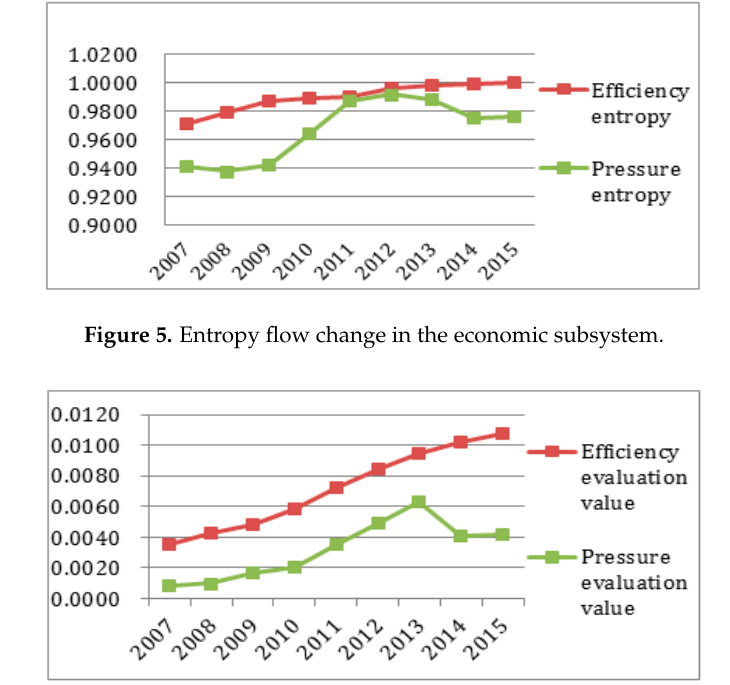
Figure 8. Evaluation value change in the ecological subsystem. Figure 9 shows that the social efficiency entropy flow has a smooth growth between 2007 and 2009, and a sharp decrease in 2010, then, it remains steady from 2010 to 2013, while at the same time, the pressure entropy flow is rising steadily and higher than the efficiency entropy flow. However, the value of the efficiency entropy and the pressure entropy is the same from 2014 to 2015. This suggests